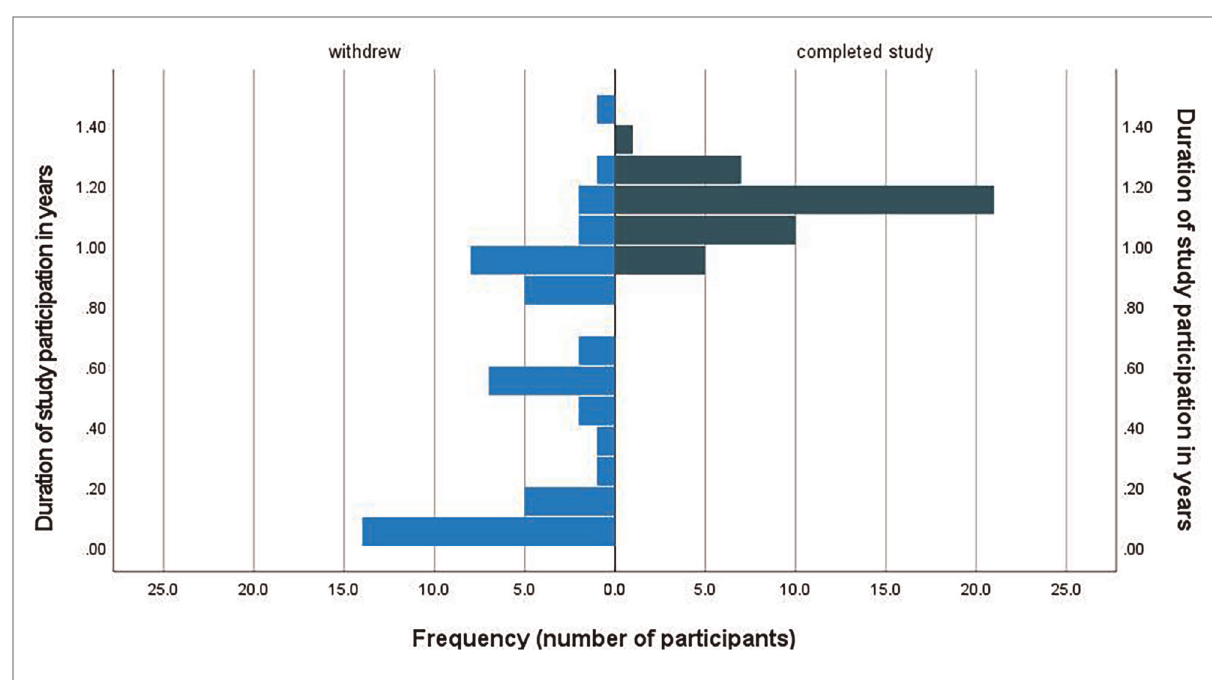
FIGURE 2 Distribution of study participation duration among participants who withdrew and who did not withdraw.